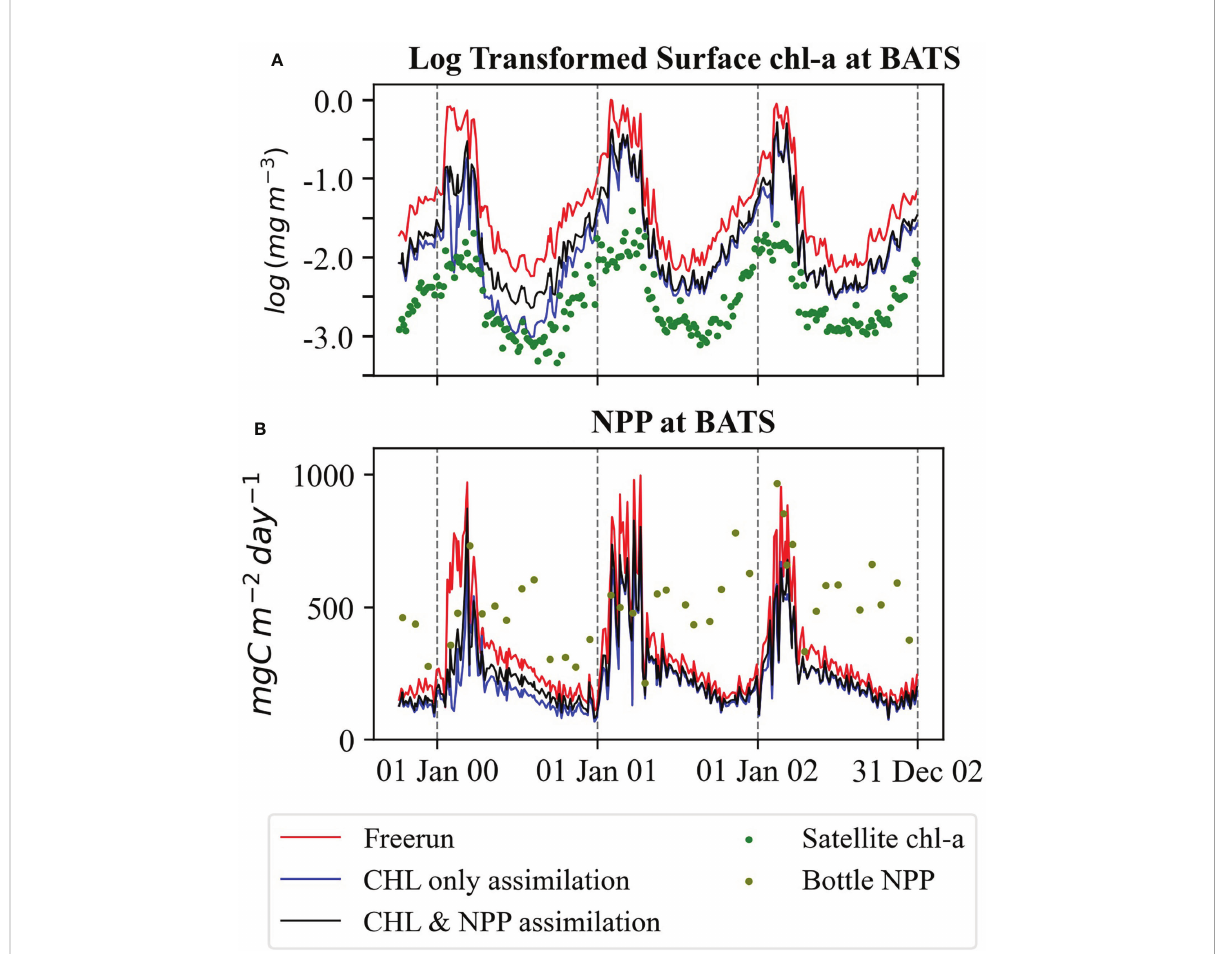
FIGURE 11 Simulated (A) log-transformed surface chl-a and (B) NPP in the parameter estimation experiments (EXP joint_DP) for free-run, satellite chl-a only assimilation, and simultaneous assimilation of satellite chl-a and in situ